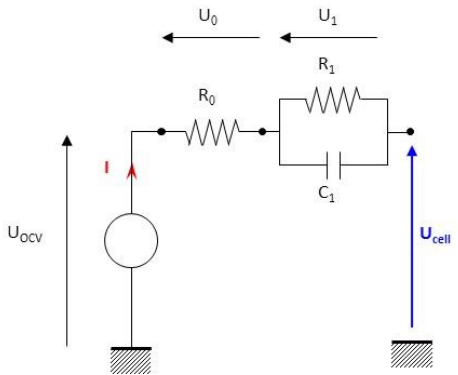
Figure 6. Diagram of the 1st-order battery electrical model.